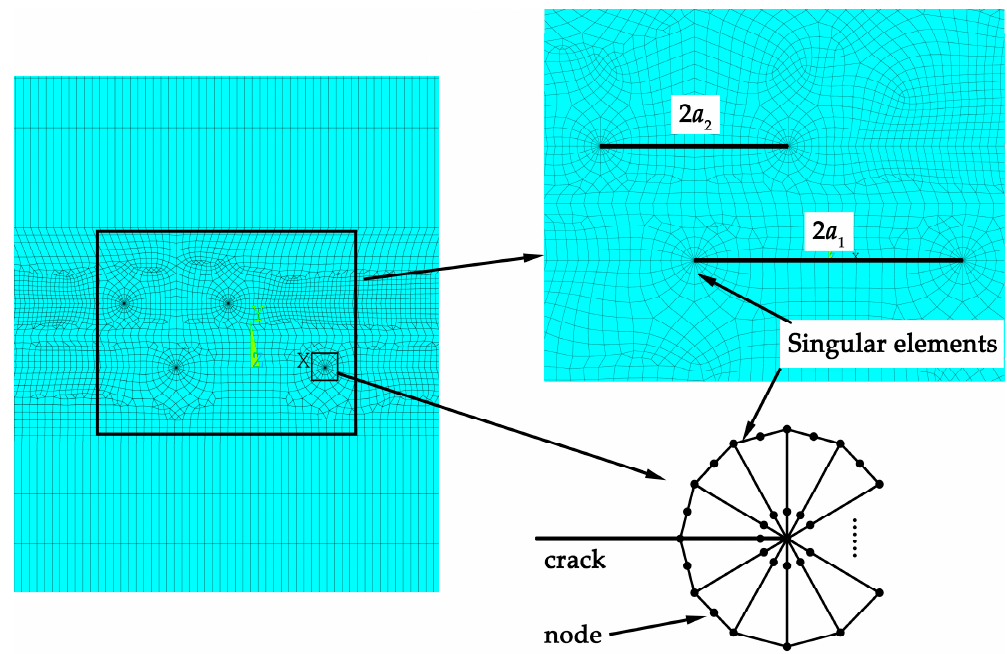
Figure 2. Mesh model of the plate with two parallel cracks.